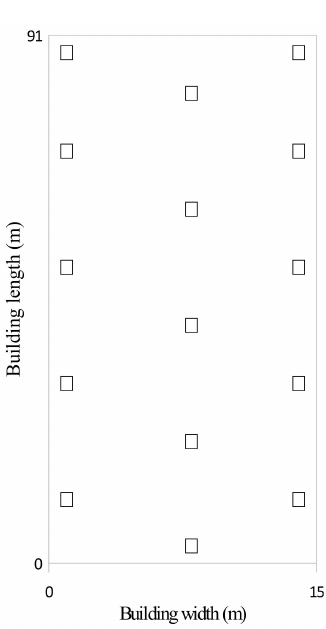
Figure 1. The distribution of insect traps in both